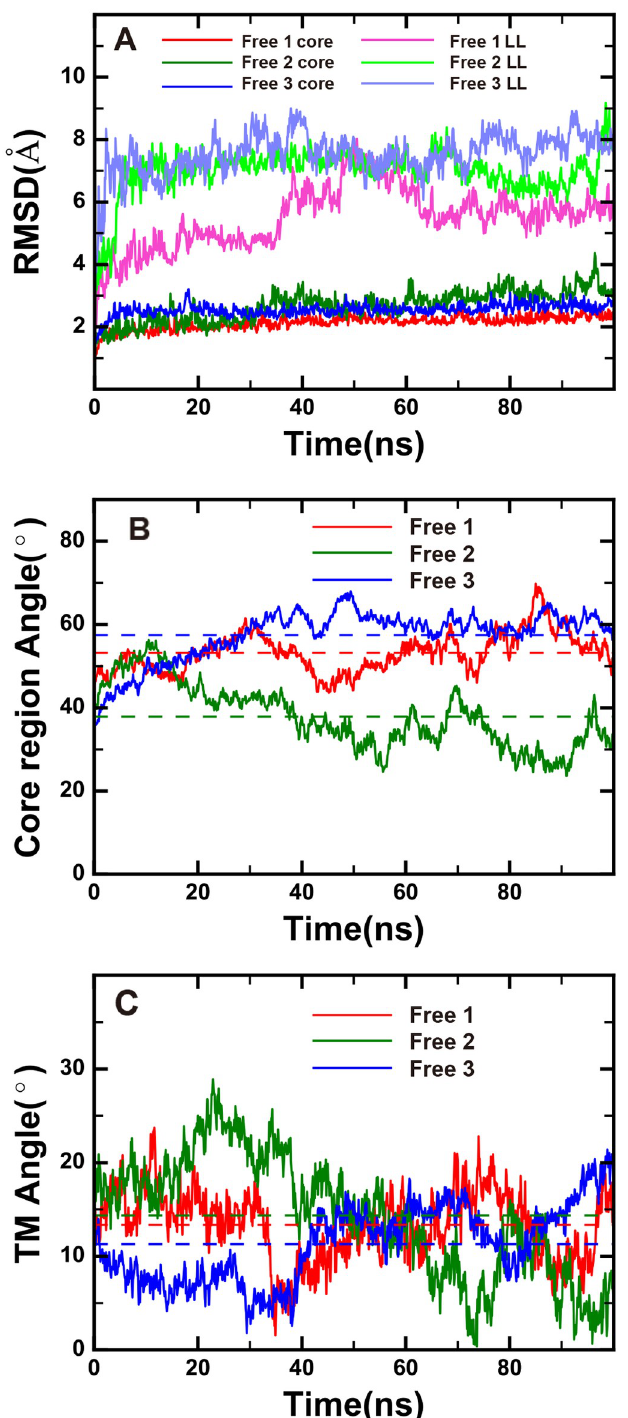
Fig 2. The free molecular dynamics simulations. (A)The RMSD of three different simulations, resutls for SNARE core domainand LL regionare shown. (B)The change of the angle betweenSNARE core domainand the membrane. (C)Changeof the angle betweenthe transmembrane domainof Syntaxin and the membrane.